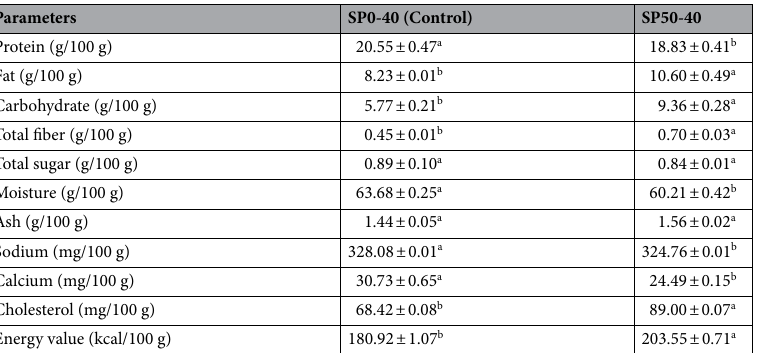
Table 4. Nutrition value of chicken bread spread and chicken bread spread-fortified with silkworm pupae. Data are expressed as mean ± standard deviation (n = 3). SP0-40 (Control): Chicken bread spread without silkworm pupae fortification using the optimum level of coconut oil obtained from experiment 2. SP50- 40: Chicken bread spread with 50% replacement of chicken by silkworm pupae using the optimum level of coconut oil obtained from experiment 2. Different lowercase superscripts within the same row indicate significant differences ( p ≤ 0.05).